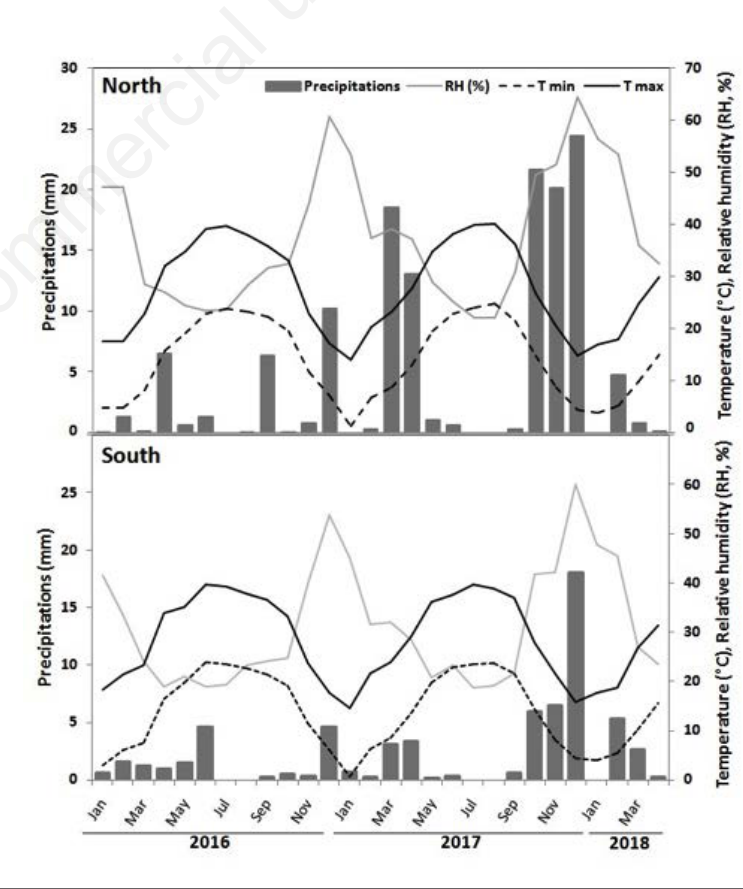
Figure 1 Average maximum (T ly rainfall and relative humidity % (RH) during 2016/17/18 annual cycles in the two study